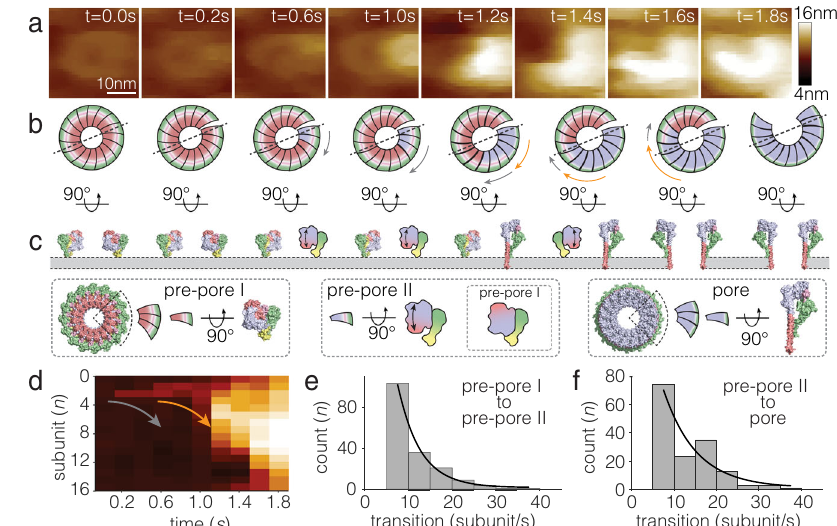
Fig.5|Three-step processofPFN2pre-poretoporetransition.a InsituHS-AFM framesofthepre-poretoporetransitionprocess. b Topviewschematicsand c side view structures and schematics of the pre-pore to pore transition in a . In the side view ( c ) pre-pore-I and pore states are represented by the corresponding struc- tures, while pre-pore-II is represented by a schematic of a pre-pore with a fl ipped